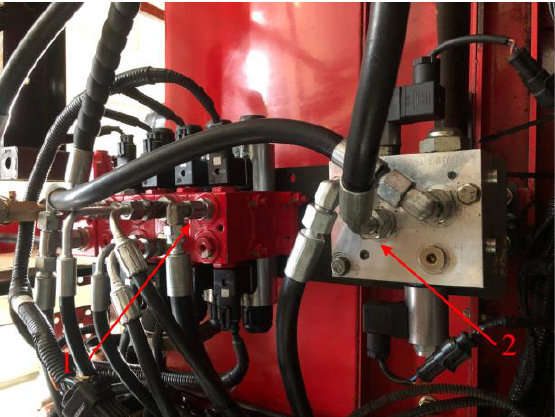
Figure 5. Structural principle of integrated solenoid proportional valve. 1. Straight check valve; 2. The 2/3-way solenoid proportional valve; 3. Hydraulic outlet pressure reducing valve; 4. The 2/2-way solenoid proportional valve; 5. Hydraulic straight-through check valve.